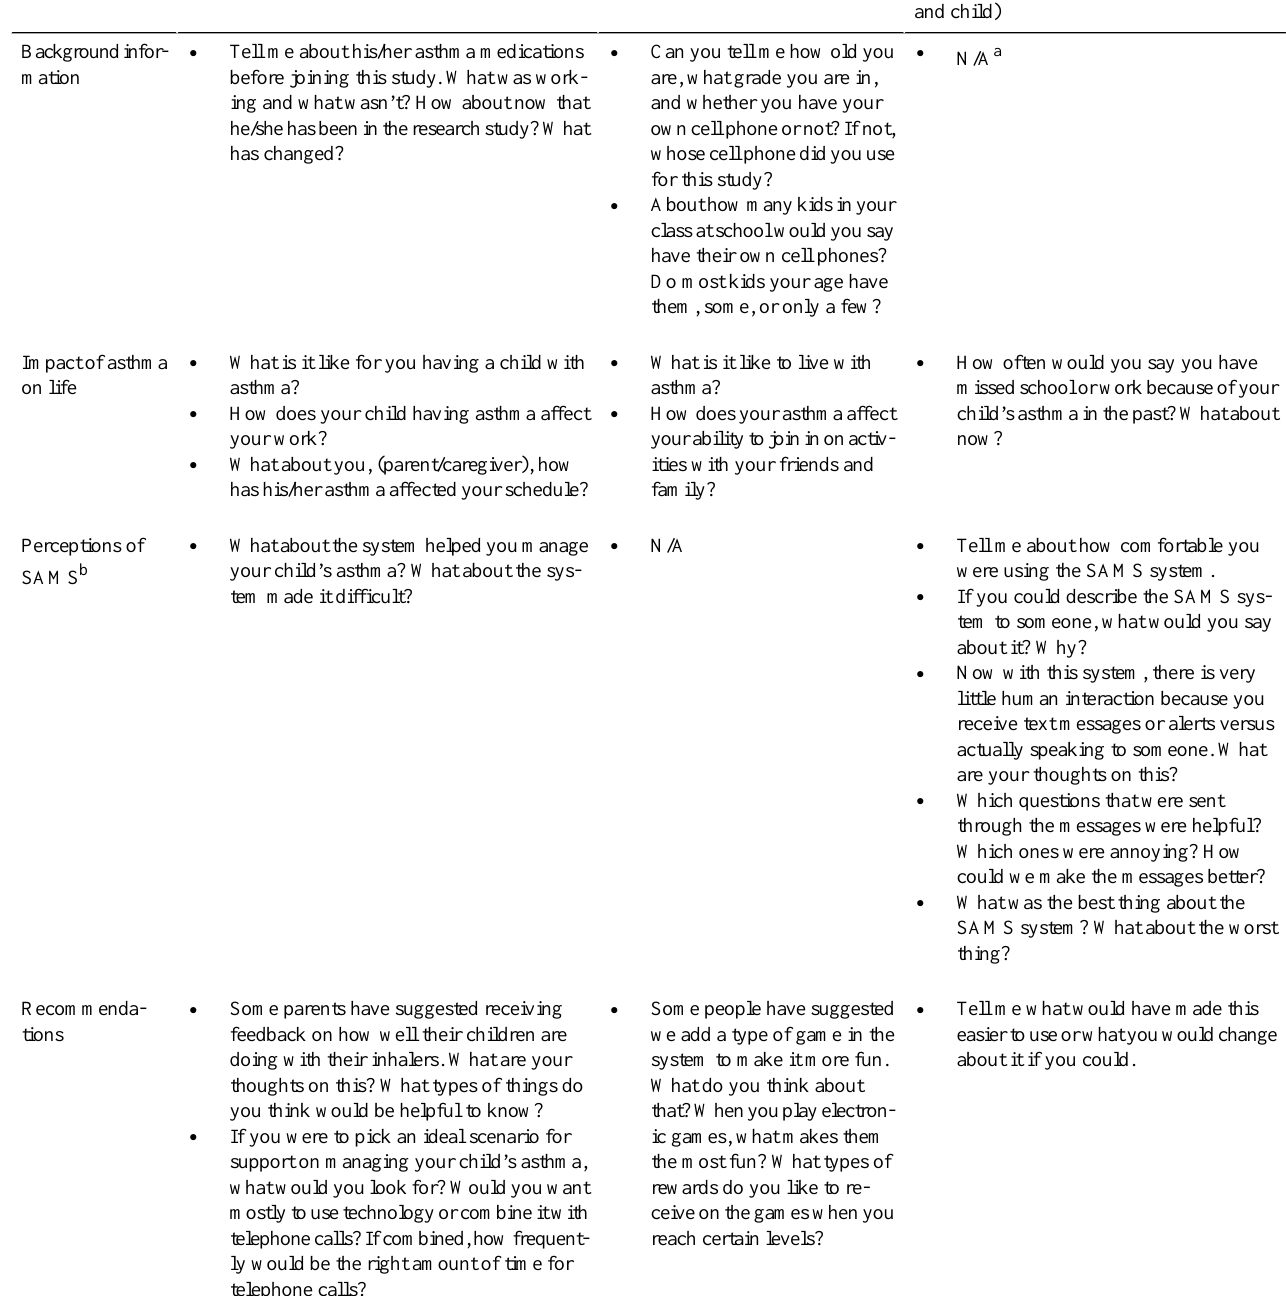
Dyad-directed interview prompts